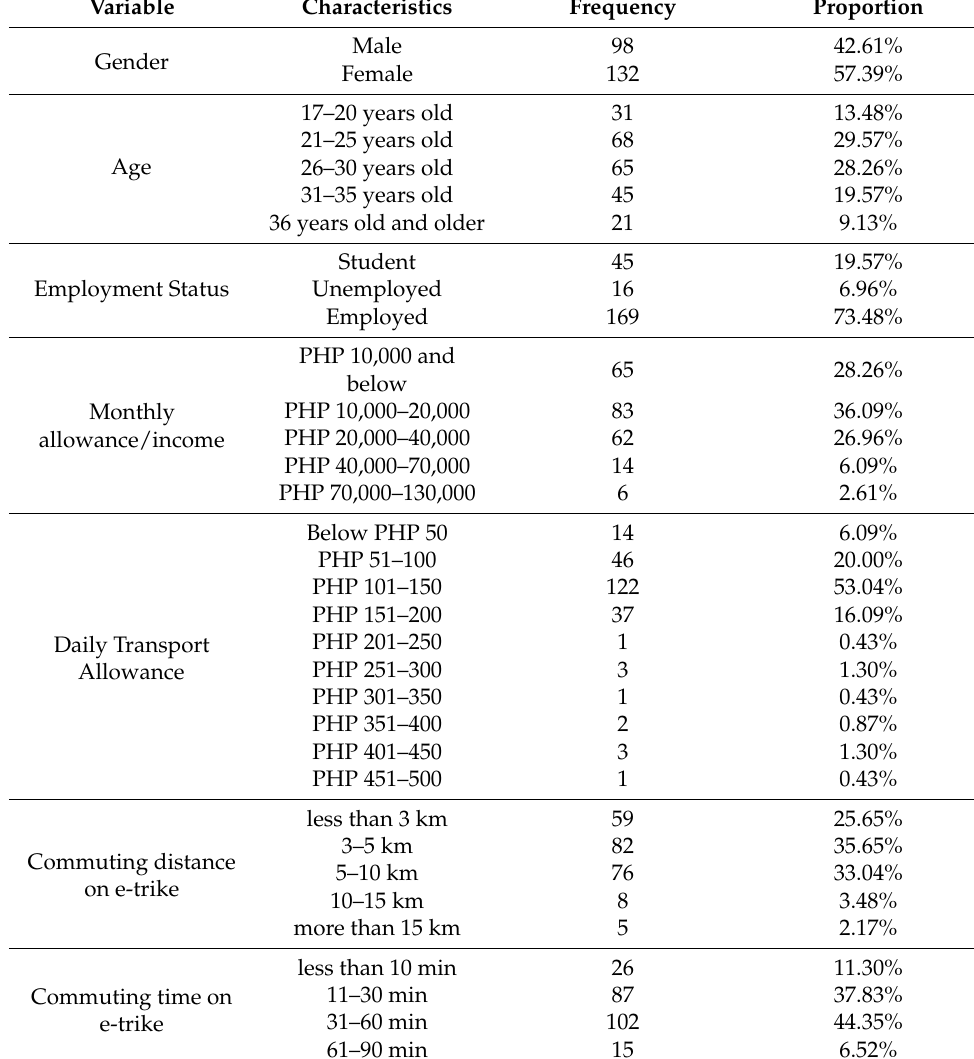
Table 4. Descriptive statistics of the demographic profile of respondents.